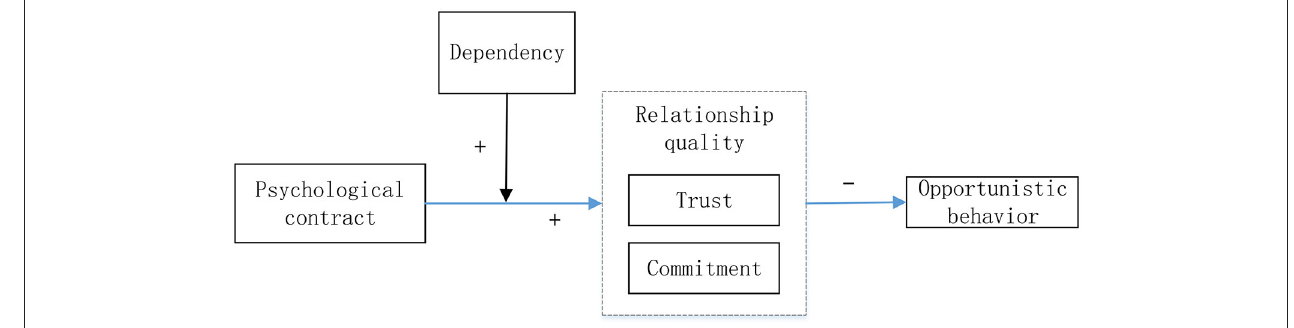
FIGURE 1 | Research